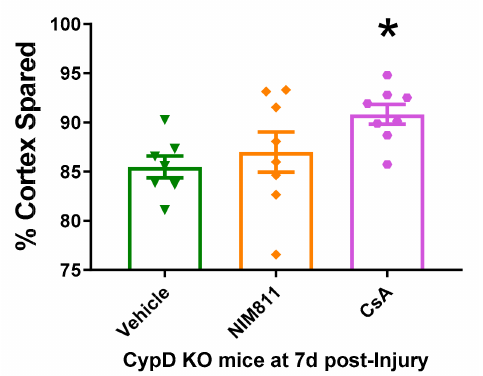
Figure 5. Cyclosporin A (CsA) and NIM811 treatment in CypD KO animals following TBI. While NIM811 did not alter tissue sparing in CypD KO animals compared to vehicle, CsA administration improved tissue sparing following experimental TBI mice. * p = 0.039 vs. Vehicle. Data points represent group mean ± SEM. N =